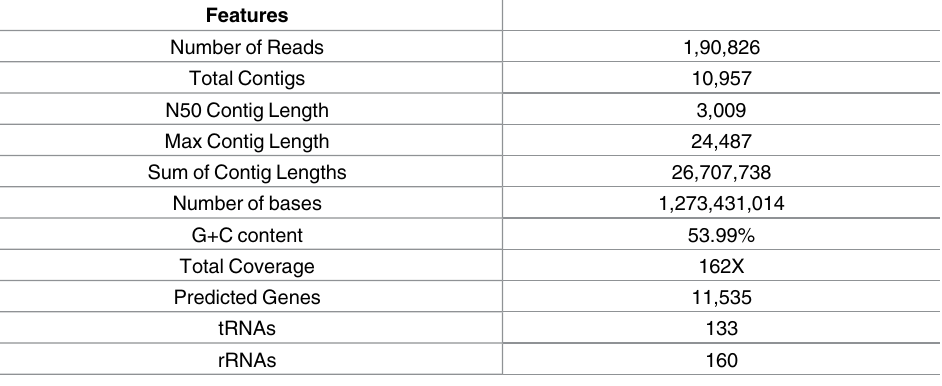
Table 2. General features of the assembly statistics of hybrid assembly of draft T . indica